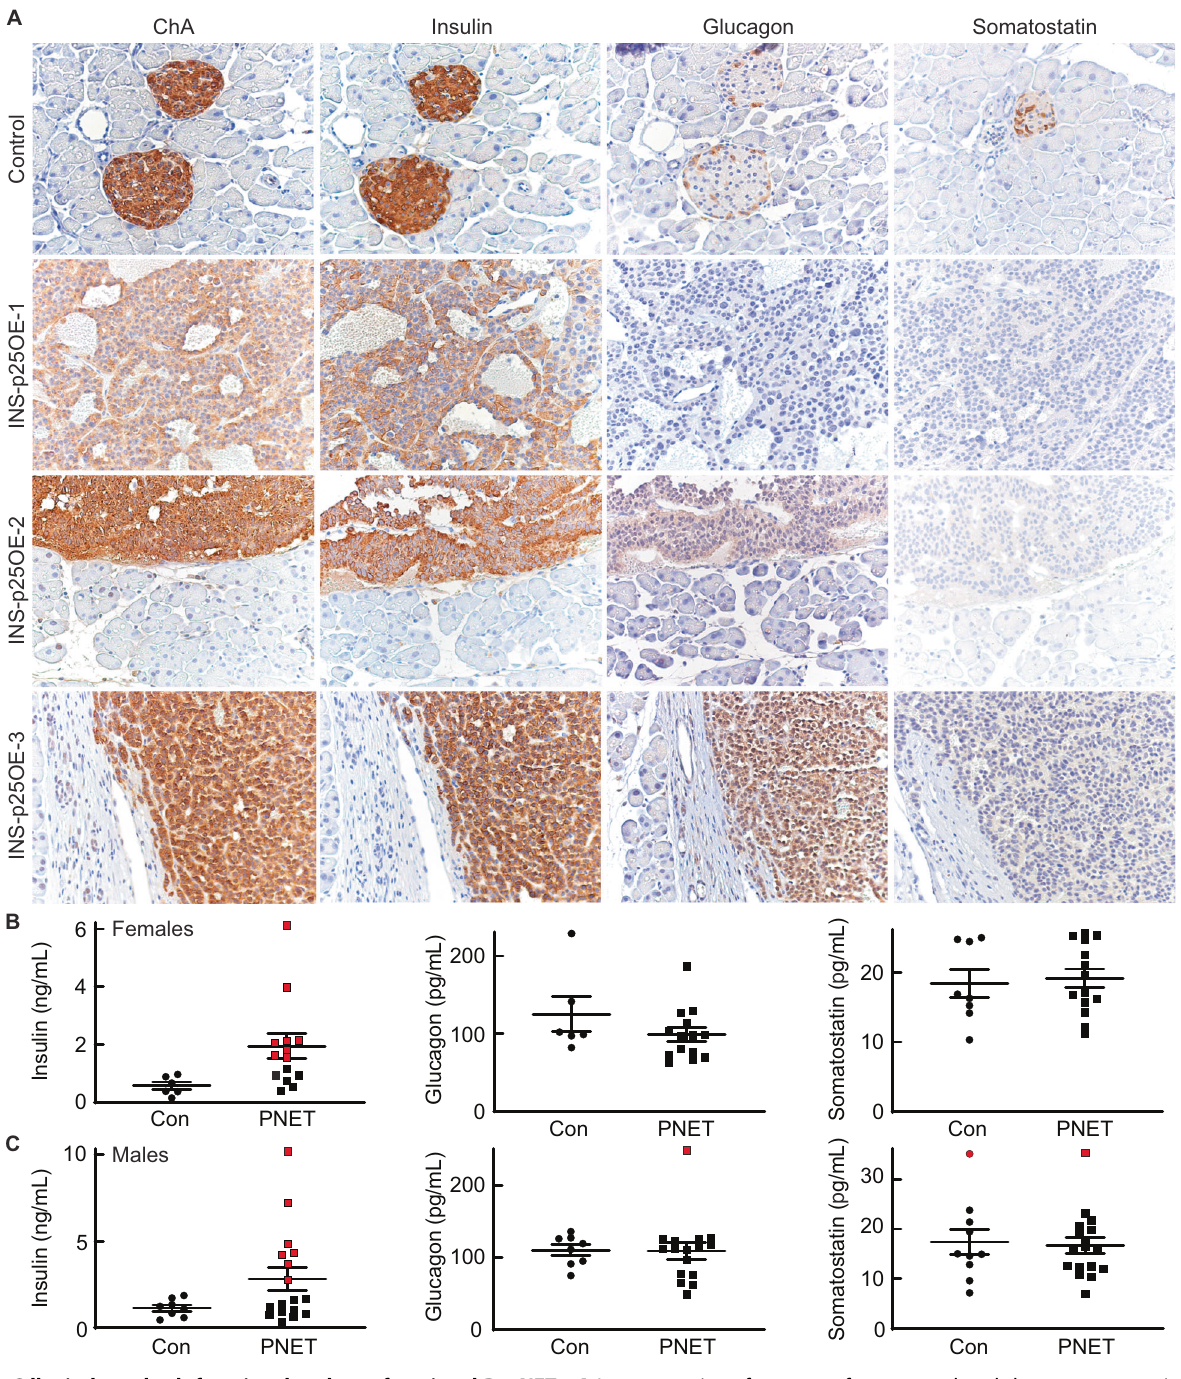
Fig. 3 Cdk5 induces both functional and non-functional PanNETs. A Immunostains of pancreas from control and three representative INS- p25OE animals. ELISA assays of hormone levels in blood plasma of female ( B ) and male ( C ) control (Con; females n = 6, males n = 8) and tumor-bearing (PNET; females n = 14, males n = 21) mice. Error bars are SEM; red points illustrate samples with levels that are two SD above the average for female possessed elevated plasma glucagon levels. In males, 2 of contained one animal with somatostatin levels elevated greater the 7 exhibited elevated plasma glucagon, one exhibited elevated than two SD above the mean of the control population, again plasma insulin, and one exhibited elevated somatostatin. falling within the natural expected Gaussian curve. Although immunostaining evaluation identi fi ed tumors that were Additionally, we tested the plasma of seven females and seven positive for both insulin and glucagon, no animals were found to males lacking large tumor masses but found to possess abnormal possess elevation of serum levels of both hormones. One animal, islets by histopathological evaluation (data not shown). Insulin was of 45 examined, exhibited elevations in both insulin and elevated in the plasma of 1 of the 7 additional females. This somatostatin. Collectively these data demonstrate that 48% of female also exhibited elevation in somatostatin. One separate